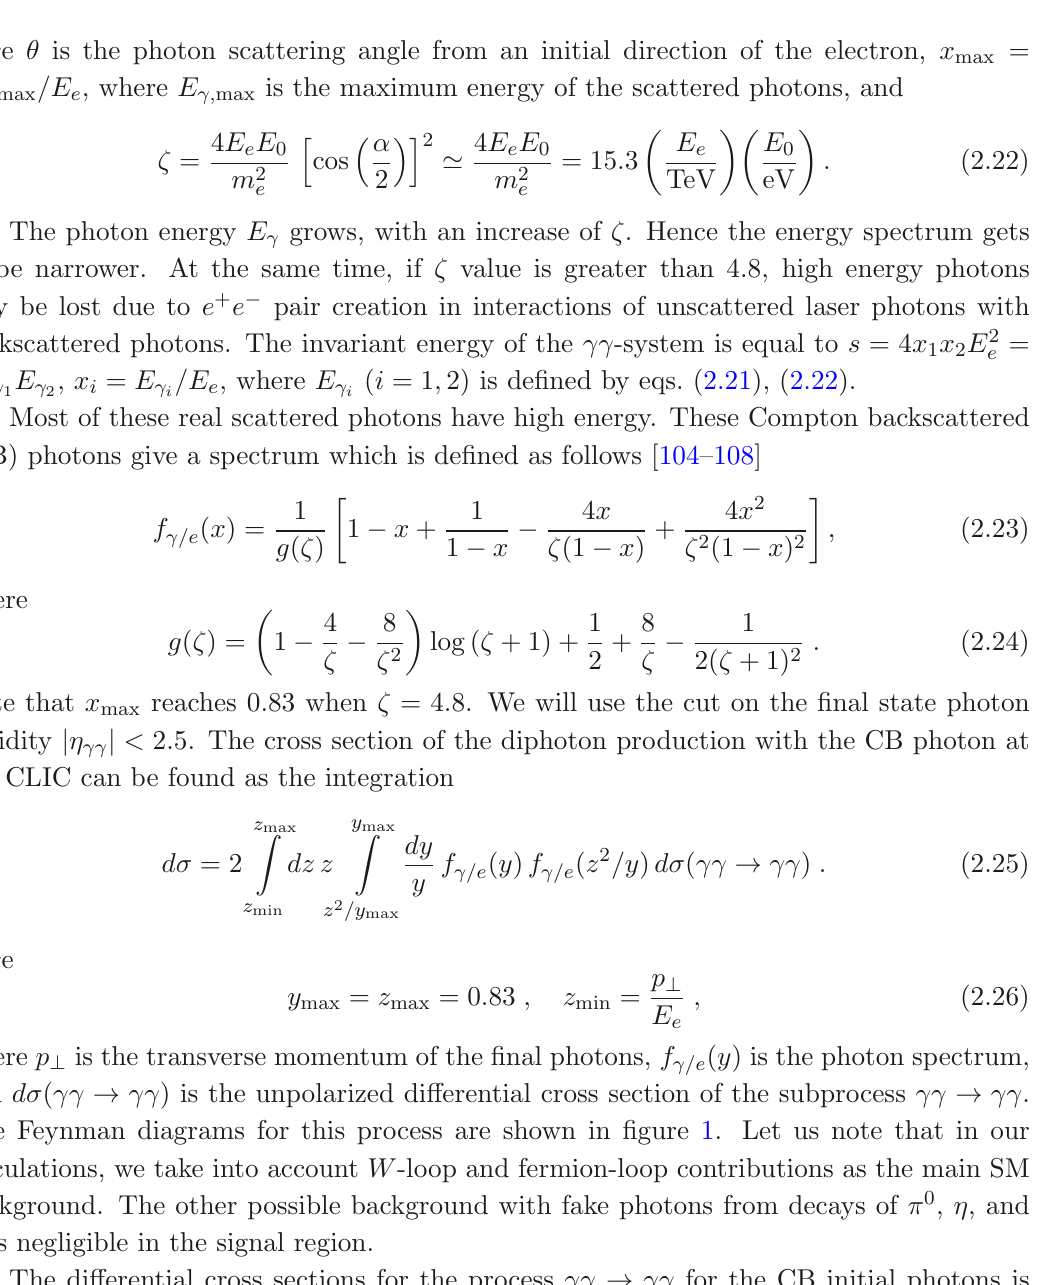
Figure 1 . The Feynman diagrams describing light-by-light virtual production of the axion-like particle a